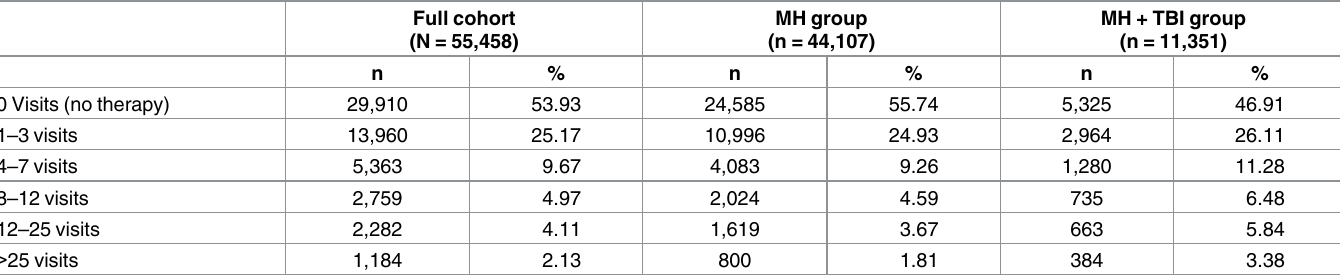
Table 3. Psychotherapy